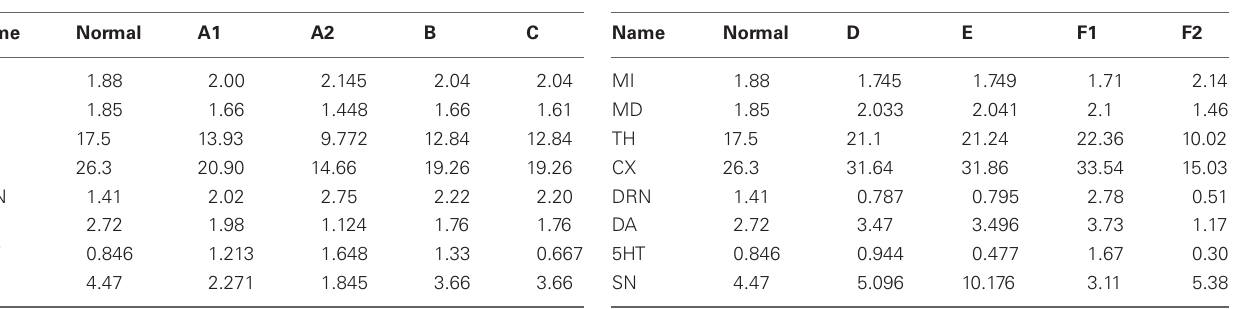
Table 3 | Results of simulations no. 1. Table 4 | Results of simulations no.